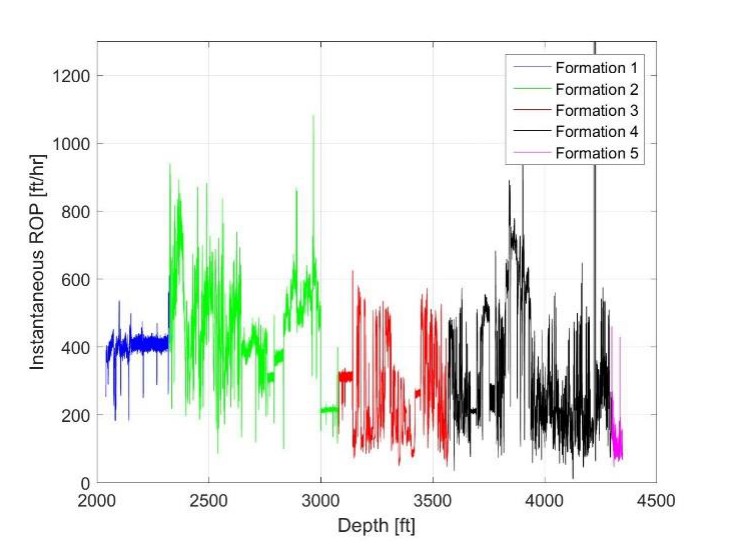
Figure 1. Well A – Instantaneous ROP